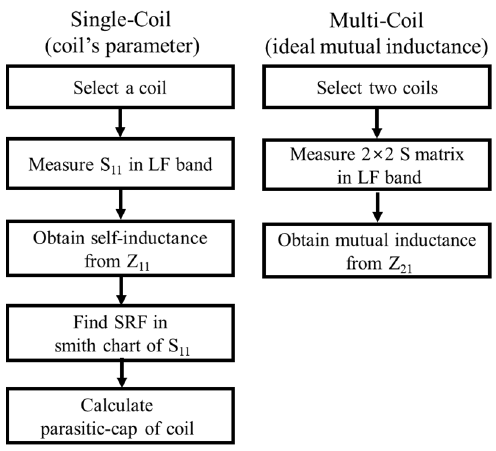
Figure 3. The procedures to obtain the coil’s parameter and the ideal mutual inductance between coils.